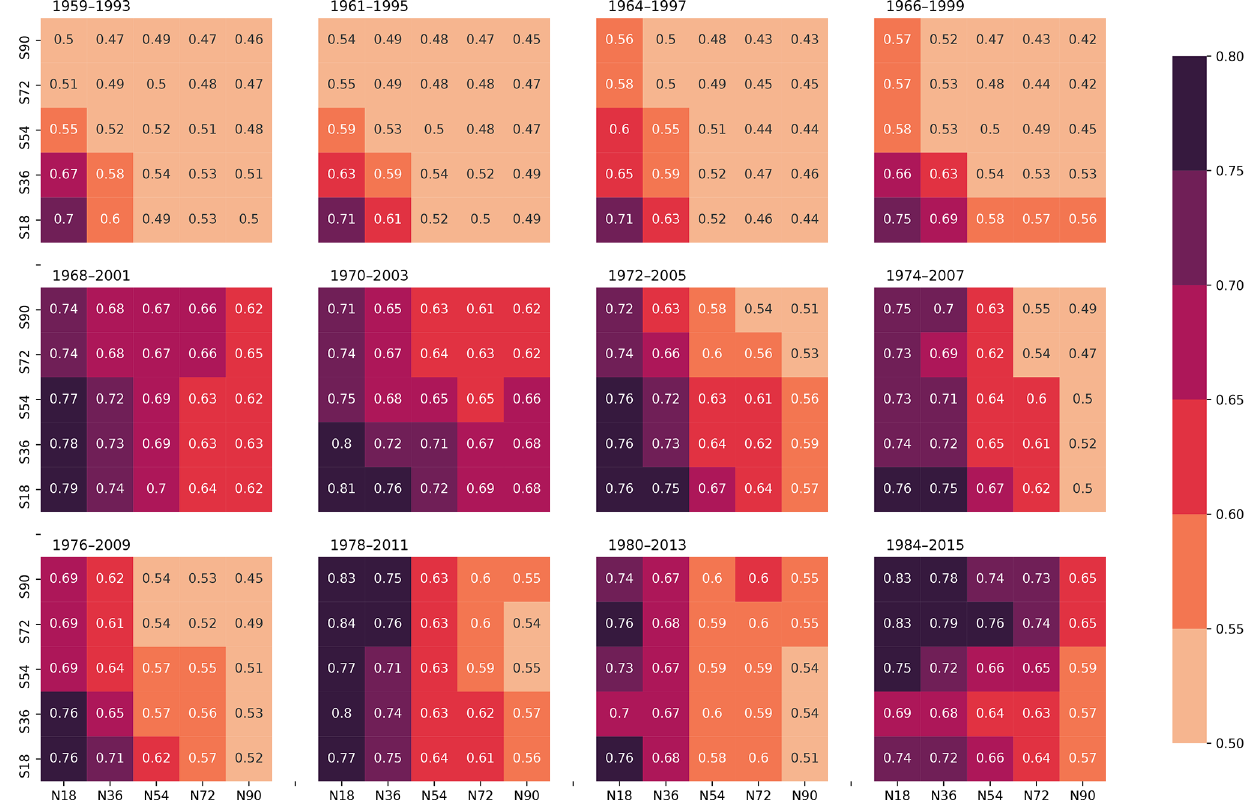
Figure 5. Predictability of AGR R with DJF SLP over various latitude domains. A 30-year sliding window in the period 1959–2017 with a 1-year step is created. The starting and end year of each interval is labeled on the top of each heat map. Here we only show the results of every second starting year; the full results are in Fig.